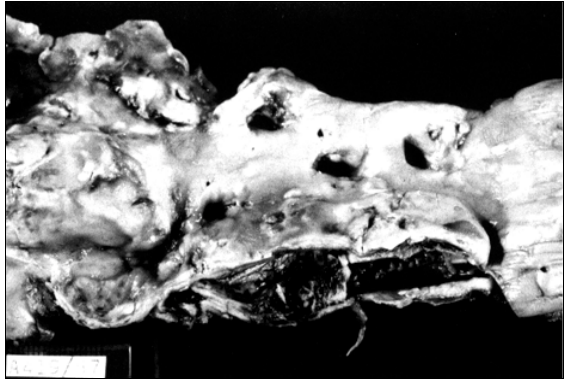
Fig. 1 - Dissecção da aorta torácica até as artérias renais com extenso hematoma na falsa luz.